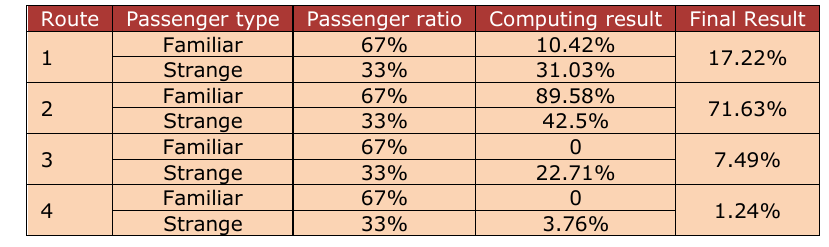
Table 6. Final Calculation